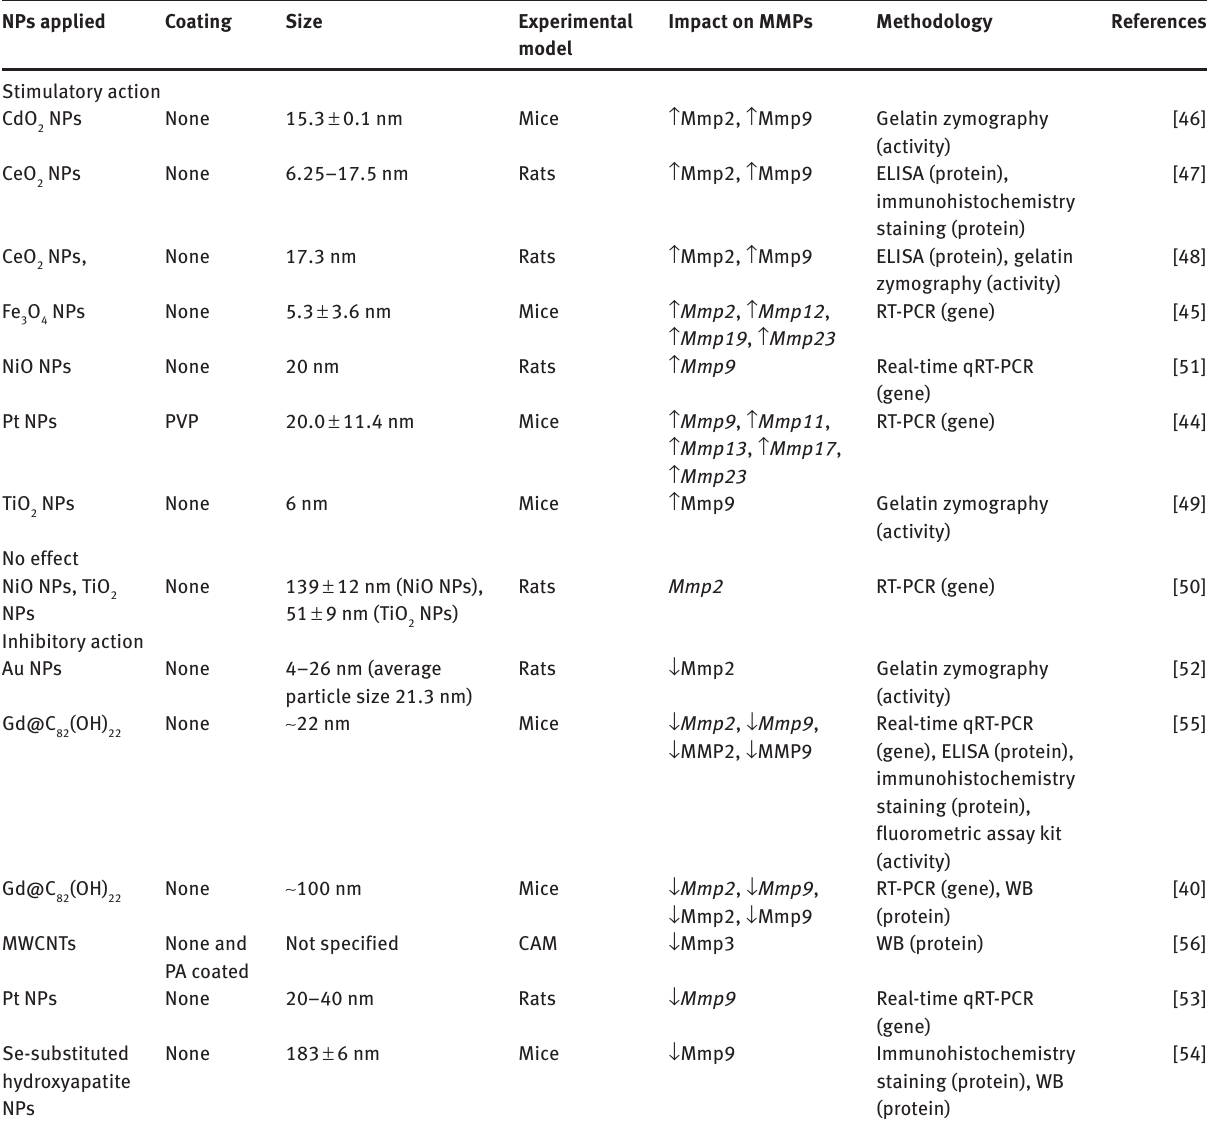
Table 2: Effect of NPs on MMPs expression and/or activity in in vivo